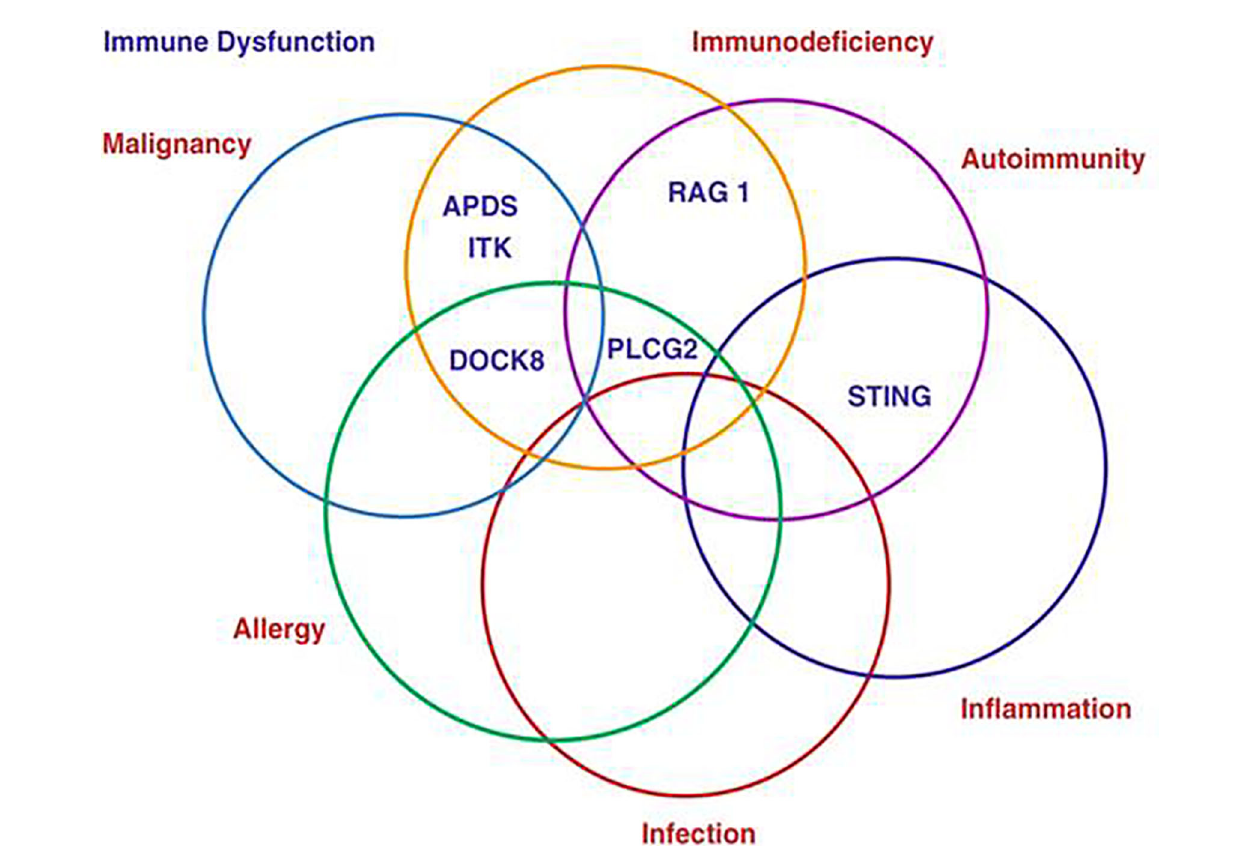
FIGURE 1 | The complexity of Primary Antibody De fi